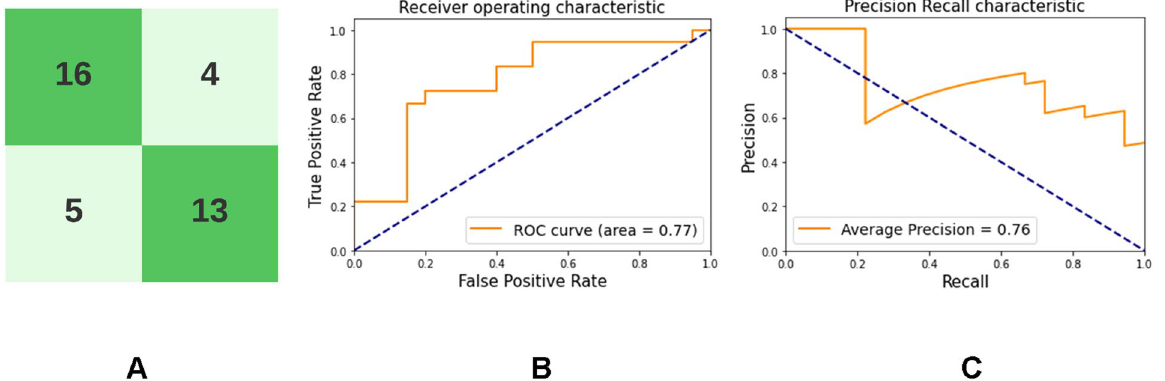
Figure 3. Performance of the classifier on test dataset. ( A ) The test dataset consists of 18 dementia and 20 control subjects. This image shows the confusion matrix. ( B ) Area under receiver operating characteristic is 0.77. ( C ) Area under precision-recall curve is